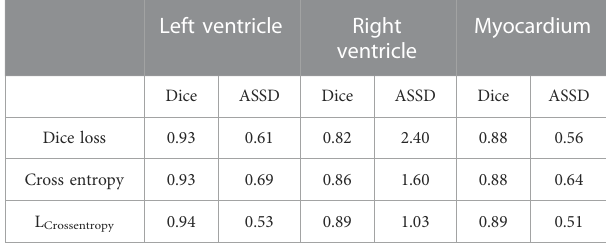
TABLE 1 Comparison of mean segmentation accuracy of three loss functions based on improved U-Net